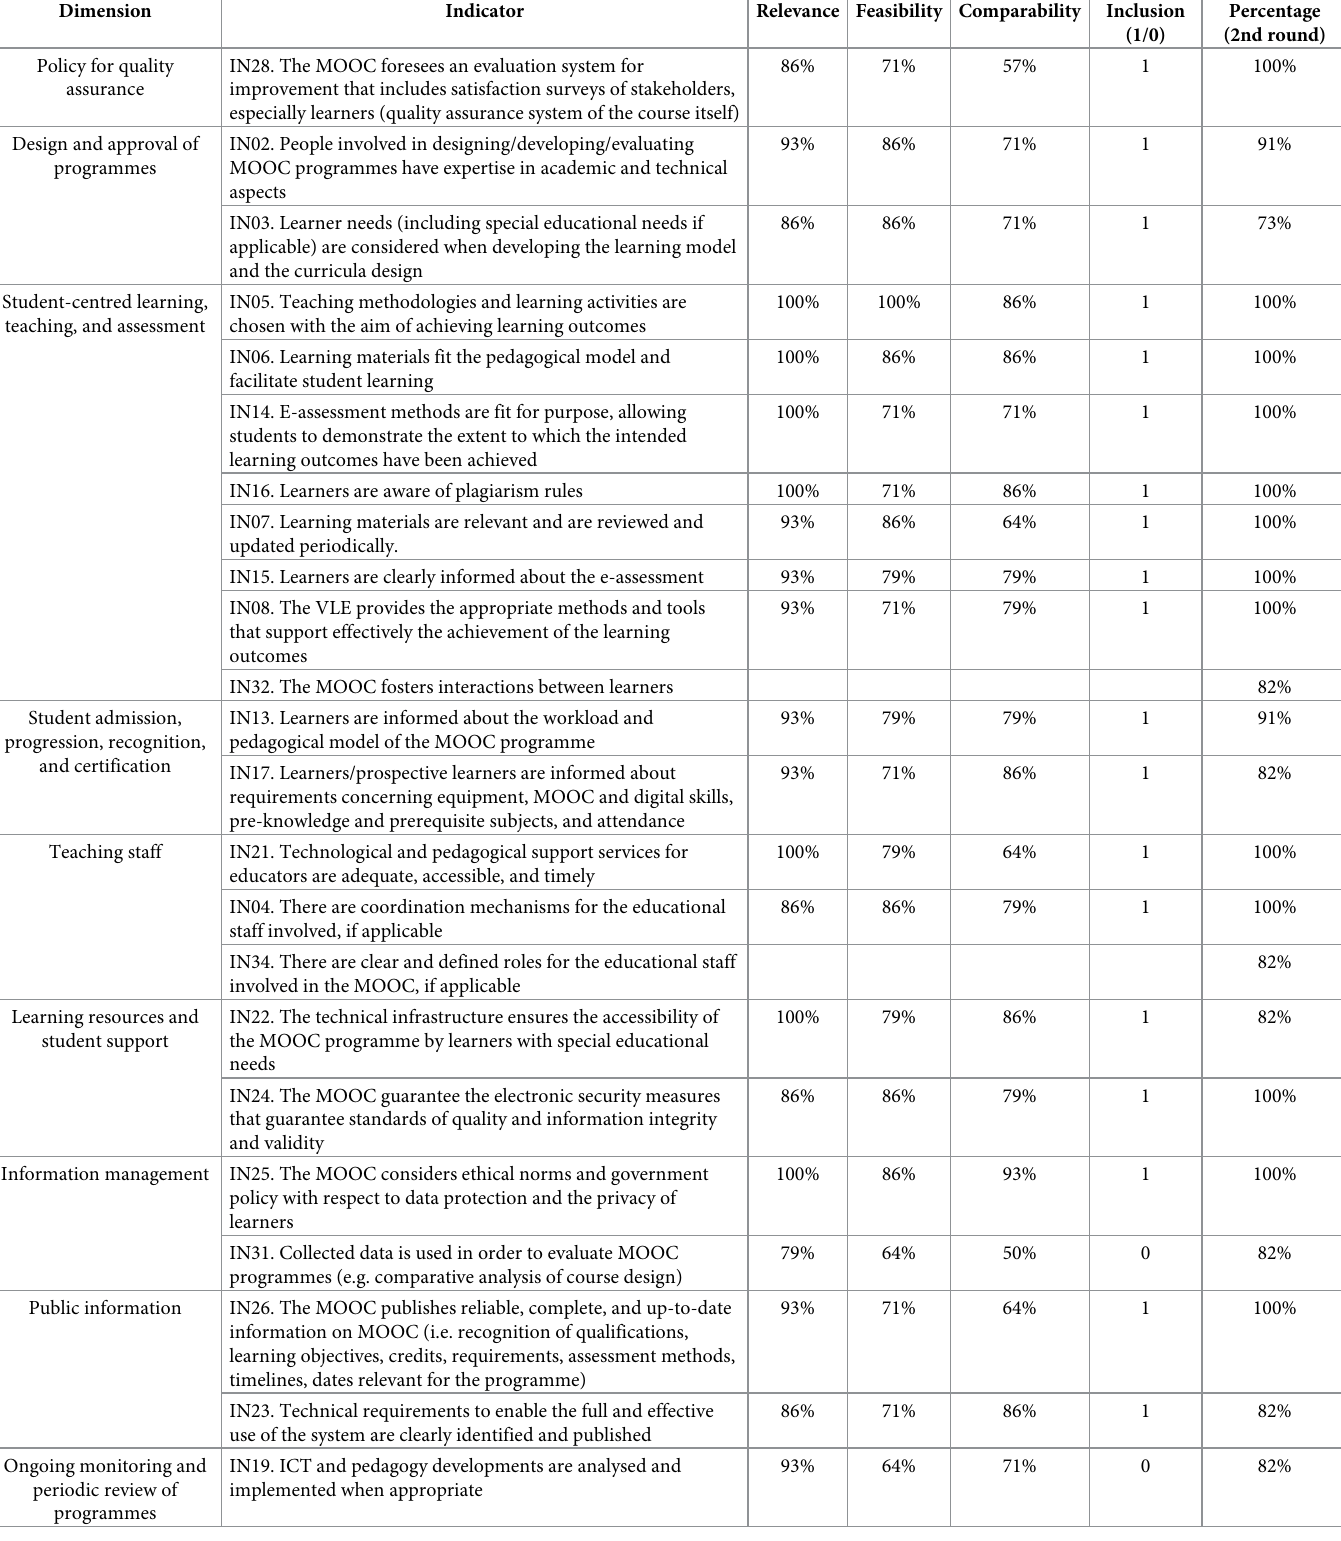
Table 3. Indicators results of the Delphi process to be included.